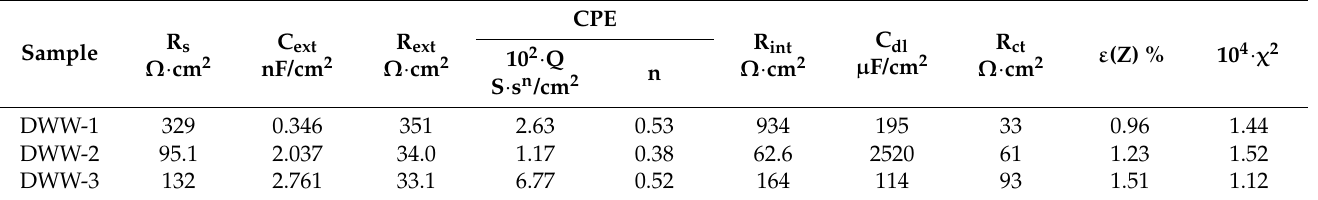
Table 8. Boukamp circuit elements parameter values R(C(R(Q(R(CR))))) for nodular cast iron samples immersed for 65 days in synthetic domestic waters.